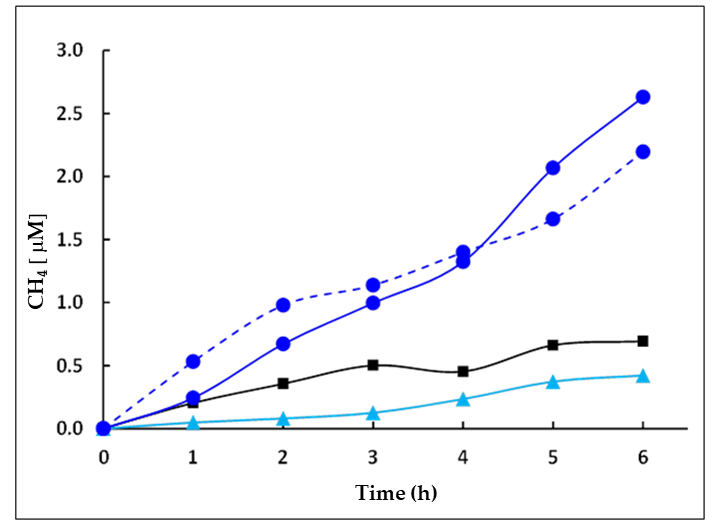
Figure 8. CH 4 evolution in the presence of TiO 2 -PHA (black line), HKUST-1 (sky blue line), TiO 2 /HKUST-1 first run (dashed blue line) and second run (continuous blue line).